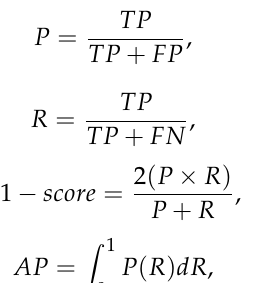
identified trees, which is the ratio between the number of correctly identified trees and the number of